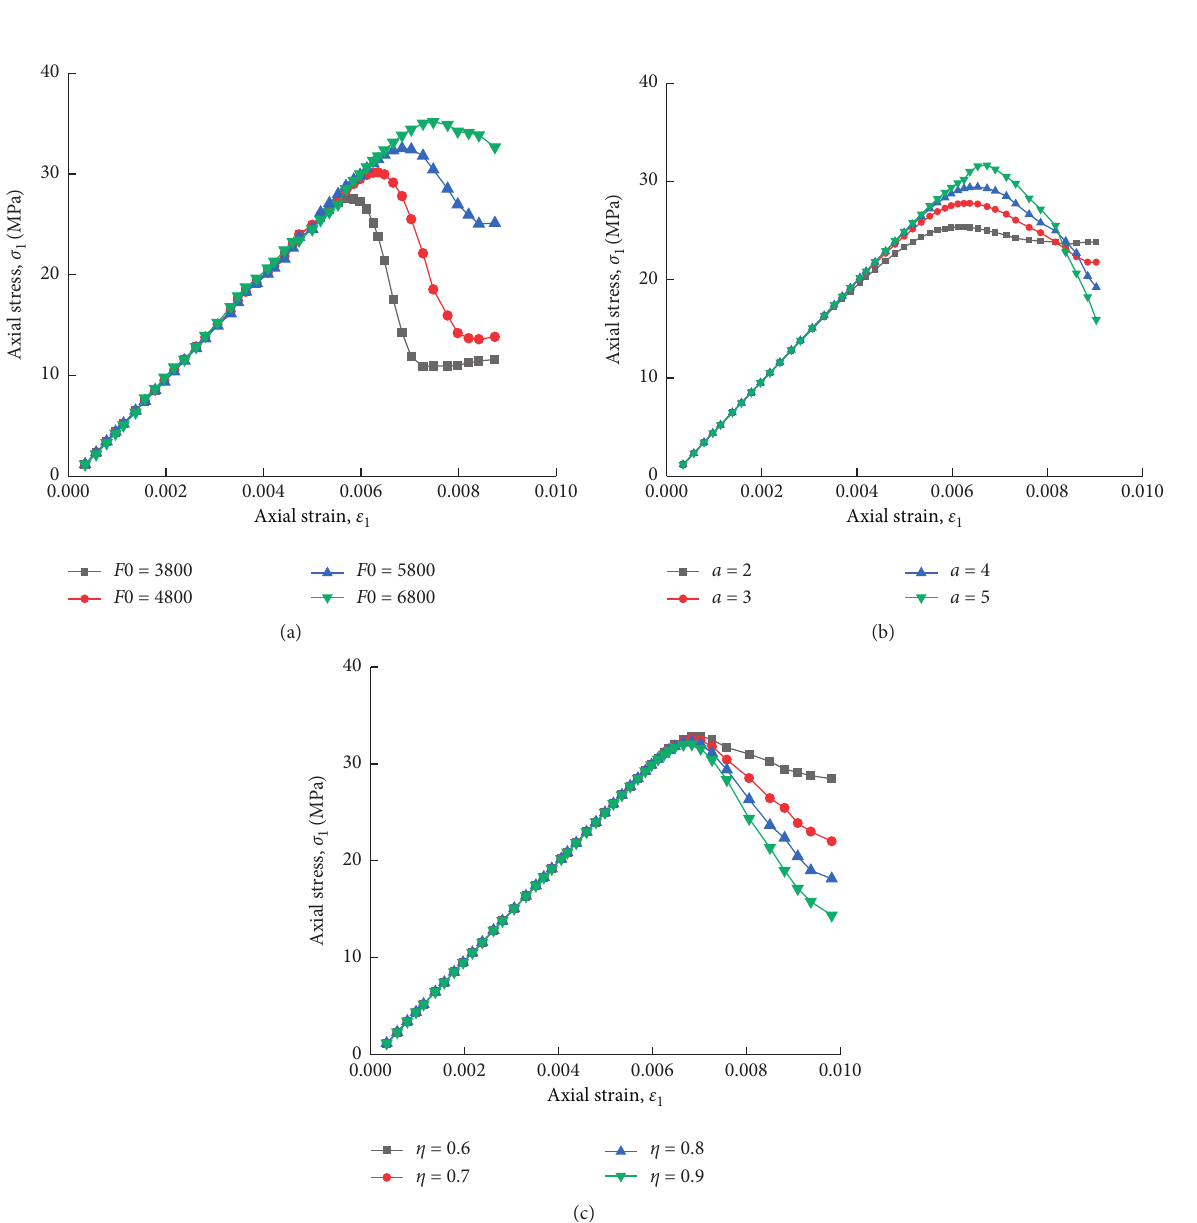
Figure 7: The curve of stress-strain of rock specimen and correction factor under different Weibull distribution parameters: (a) different parameters F , (b) different parameters a , and (c) different correction factors η 0